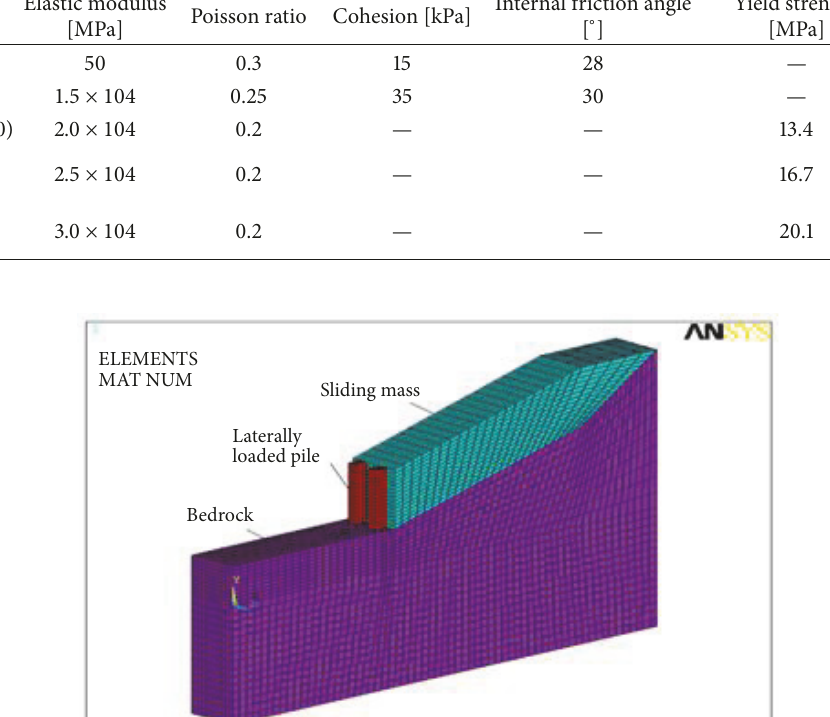
Figure 11: The calculated model.